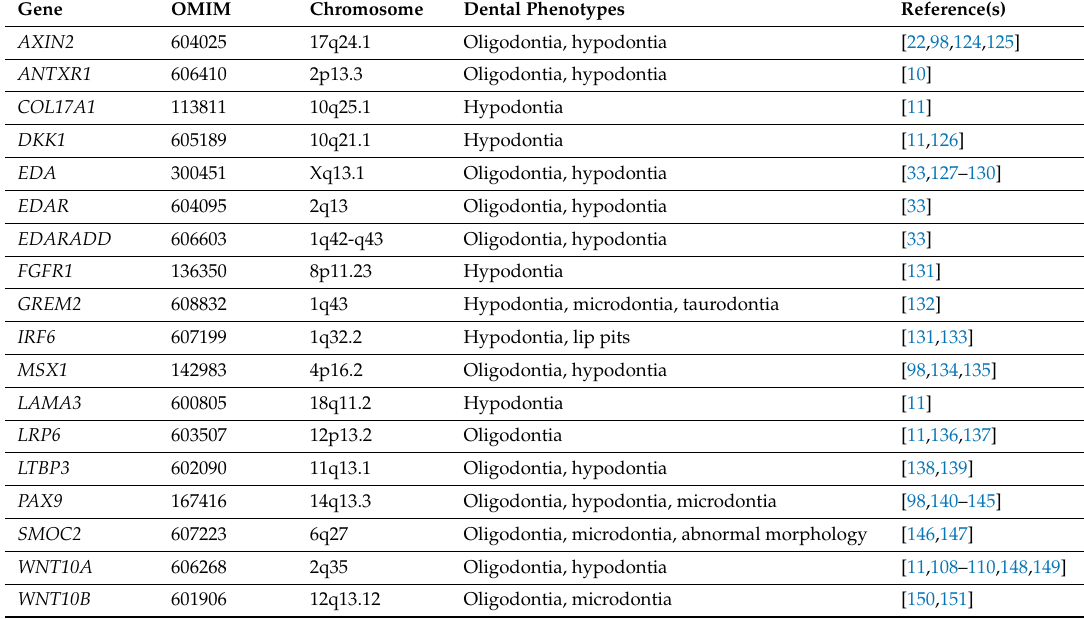
Table 2. Genes involved in isolated tooth